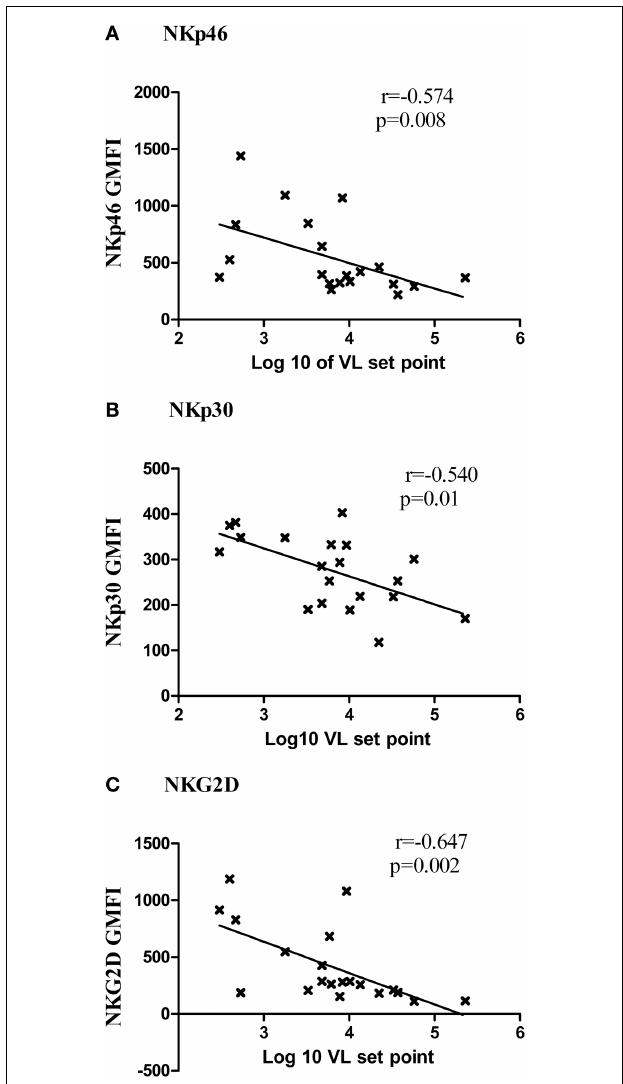
FIGURE 6 |Association of expression of activating receptors and viral load set point .The G-MFI of NKp46 (A) , NKp30 (B) , and NKG2D (C) is plotted on Y axis and the log of viral load set point is shown on the X